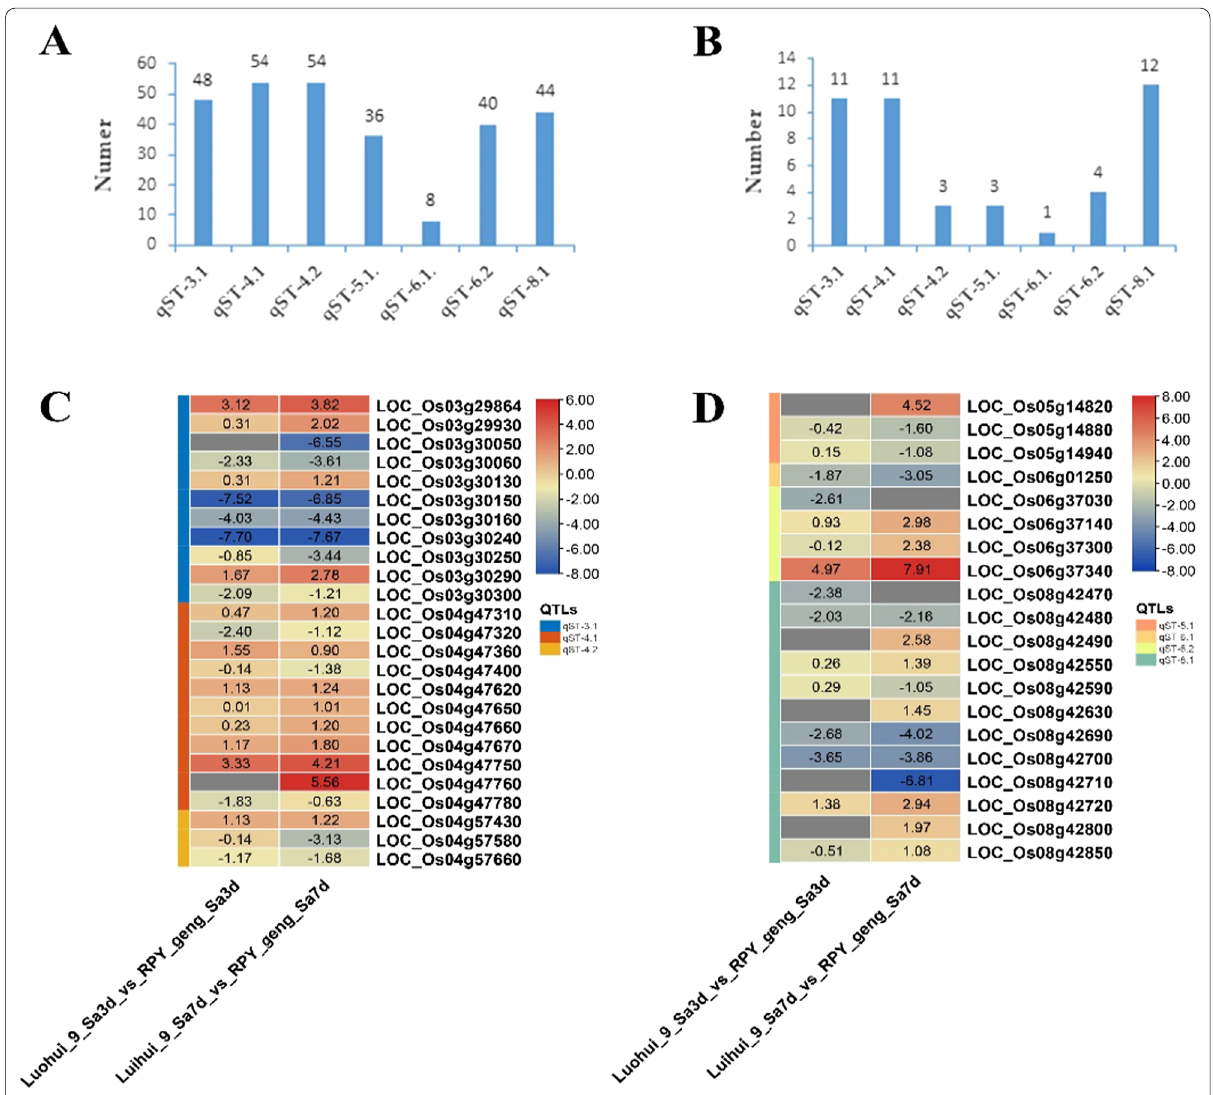
Fig. 7 DEGs analysis in QTLs. A Statistics of the number of genes in QTLs; B Statistics of the number of DEGs in QTLs; C , D Heat map of DEGs in QTLs. Note Sa3d and Sa7d mean salt treatment (100 mM NaCl Yoshida solution) for 3 days and for 7 days,